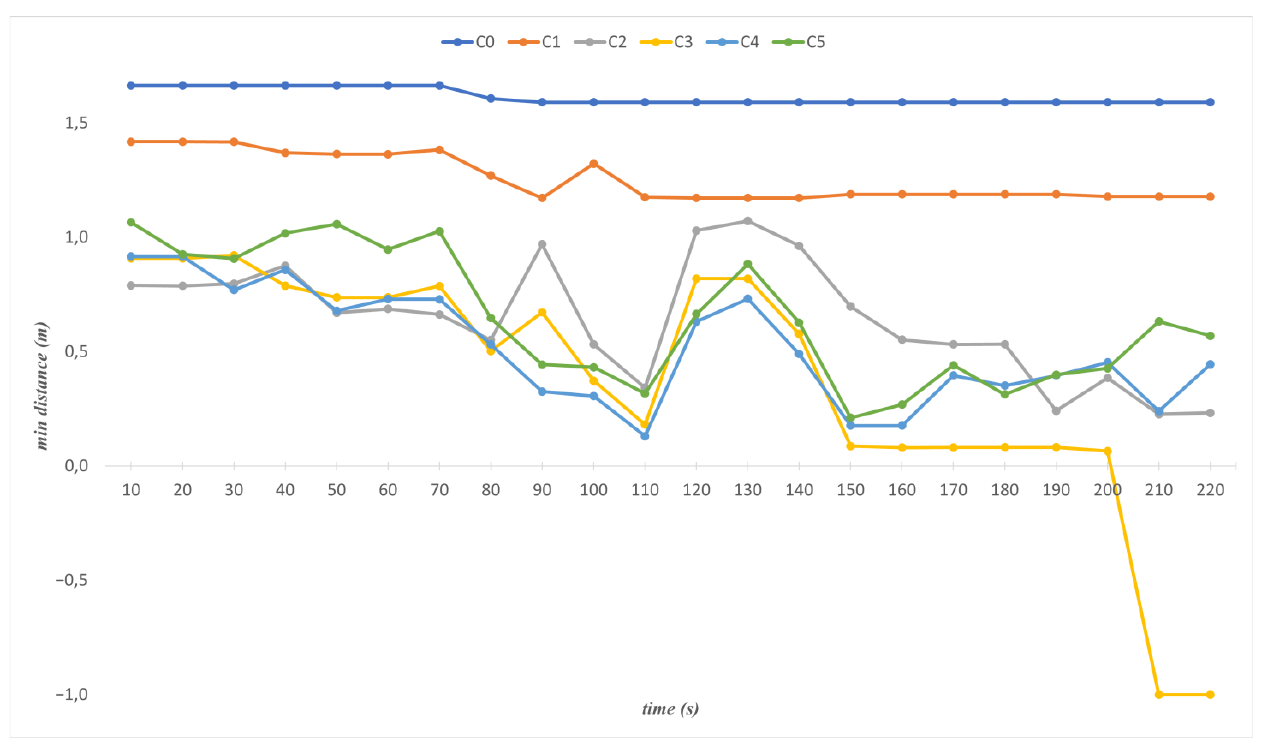
Figure 15. Minimum distances for each cylinder (C0 to C5).